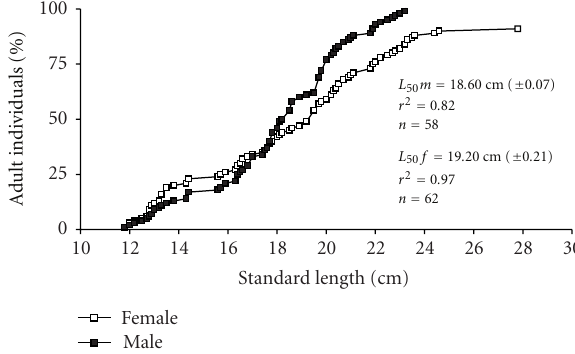
Figure 4: Size at first sexual maturity of females and males of Prochilodus brevis